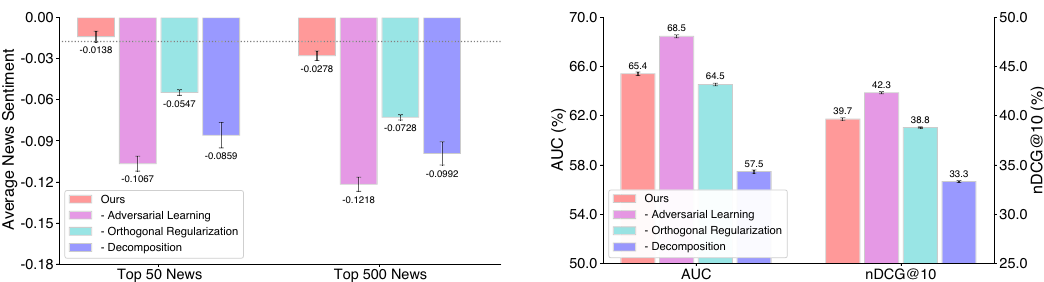
Fig. 7 Effectiveness of the core techniques used in our approach. The contribution of each module is evaluated by the changes in sentiment bias and recommendation performance when removing it from our approach. Left: the sentiment bias is indicated by the average sentiment of the top 50 and top 500 news. The dashed line represents the unbiased benchmark. Right: the recommendation performance is indicated by the AUC and nDCG@10 scores. The adversarial learning mechanism contributes most to the removal of sentiment bias. The orthogonal regularization technique improves model performance and decreases sentiment bias. The decomposition framework has a major contribution to the model performance. Differences between different bars are signi fi cant ( p < 0.01 in the left fi gure and p < 0.001 in the right fi gure according to the two-sided t -test). Error bars stand for mean scores with 0.95 con fi dence intervals ( n = 5 independent